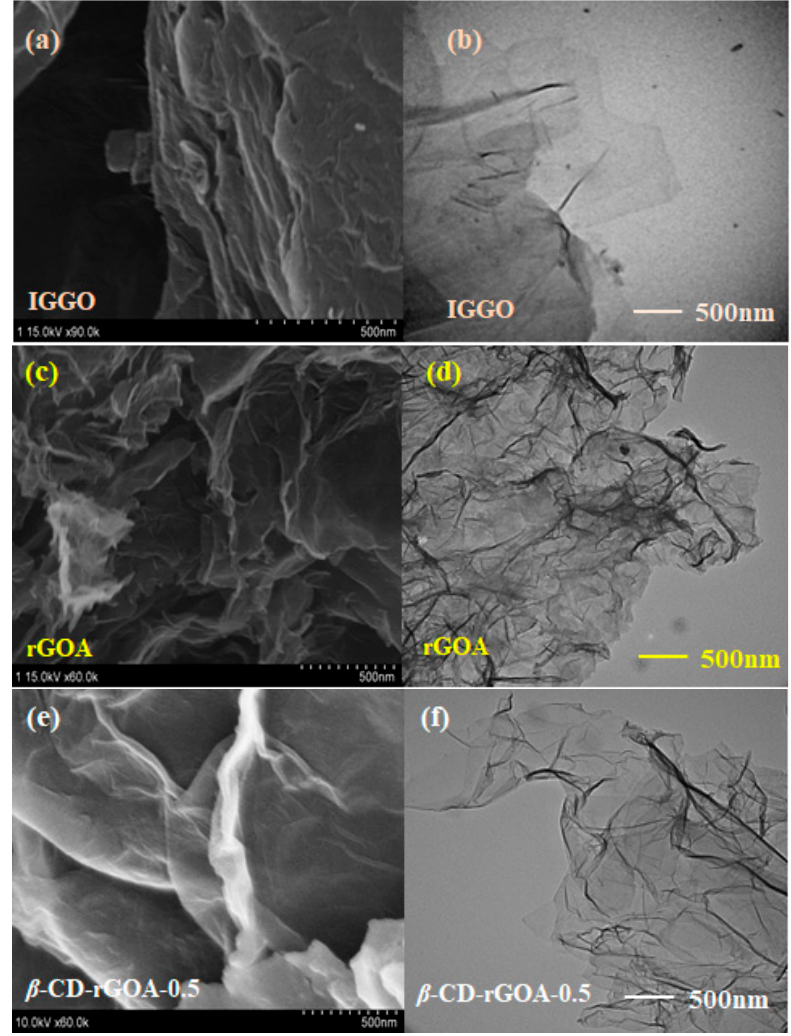
Figure 3. SEM images ( a , c , e ) and TEM images ( b , d , f ) of IGGO, rGOA, and β -CD-rGOA-0.5.